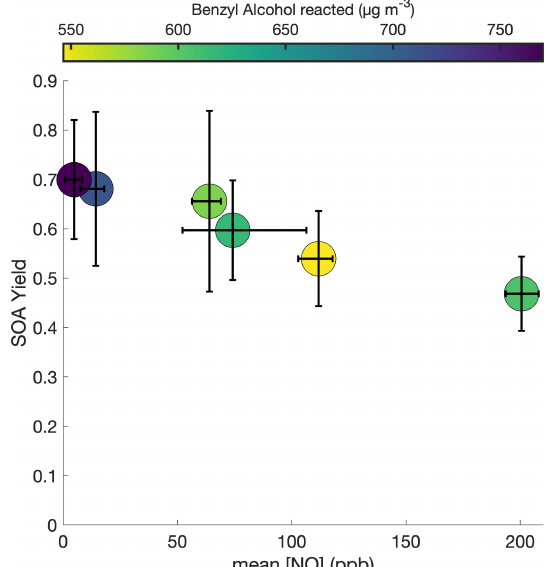
Figure 9. SOA yield under different constant [NO] conditions for experiments N1–N6. To maintain the desired NO mixing ratio, NO was injected throughout these experiments at varying rates. All ex- periments were performed at 291K, with initial benzyl alcohol mix- ing ratios between 70 and 82ppb, and with initial seed surface area concentrations of 1800 to 2900µm 2 cm − 3 . The x -axis error bars show the full range of NO concentrations experienced throughout the experiment.